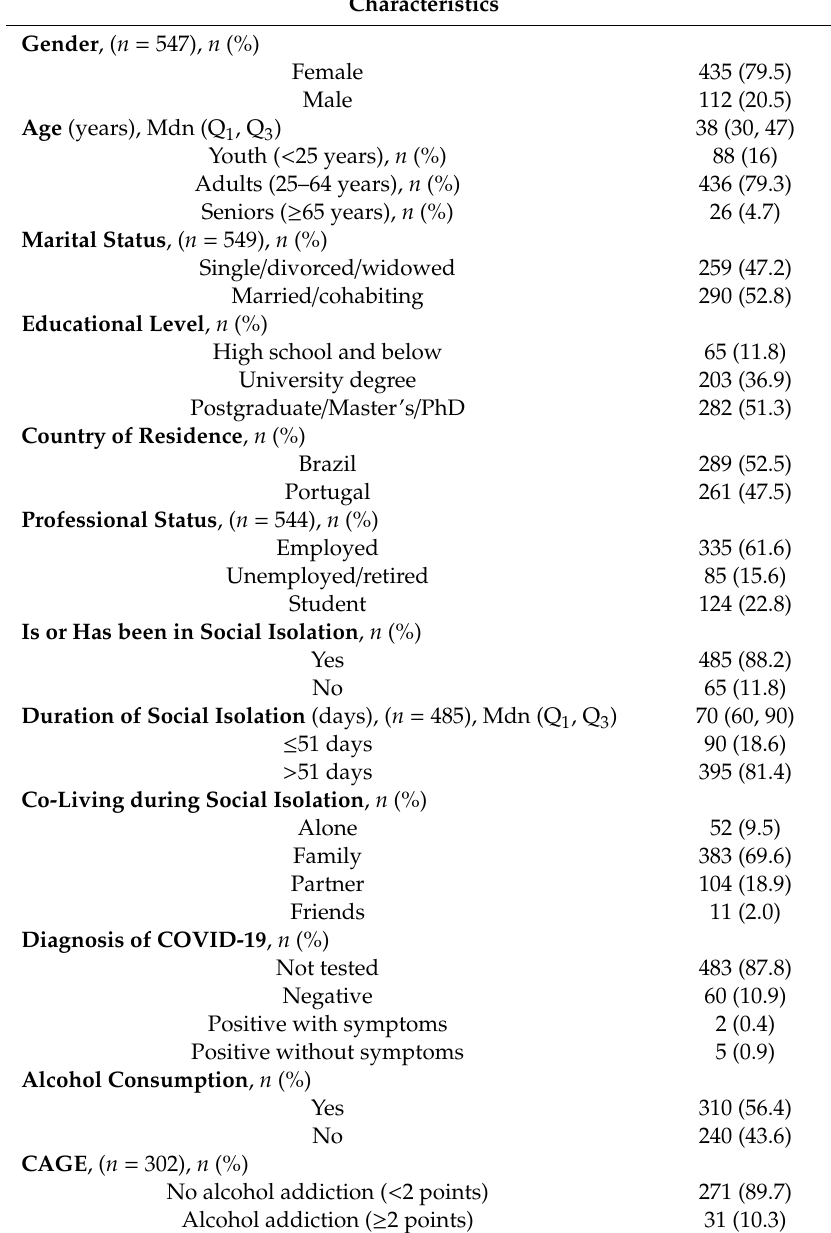
Table 1. Socio-demographic data ( n =